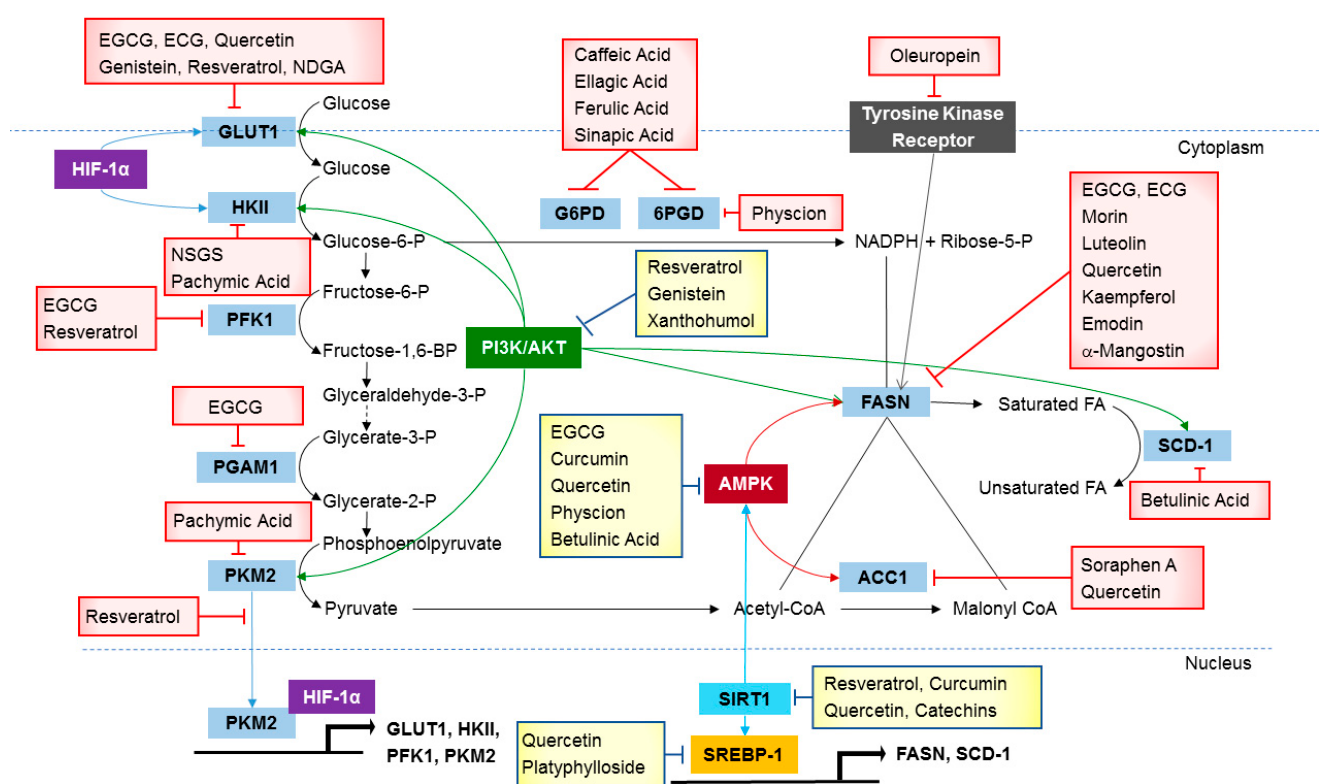
Figure 1. Metabolic pathways active in cancer cells are directly inhibited by naturally occurring compounds.